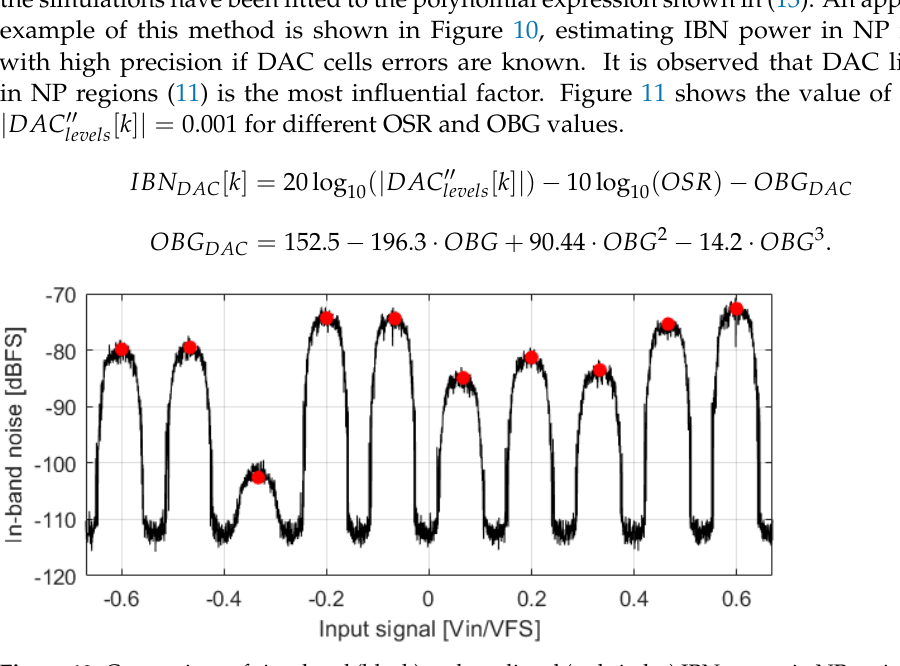
Figure 10. Comparison of simulated (black) and predicted (red circles) IBN power in NP regions when the DAC cells errors are known. Σ∆ M parameters are: fourth-order, 4-bits, OSR = 32, OBG = 1.8. Output signal is divided in segments of 3.2